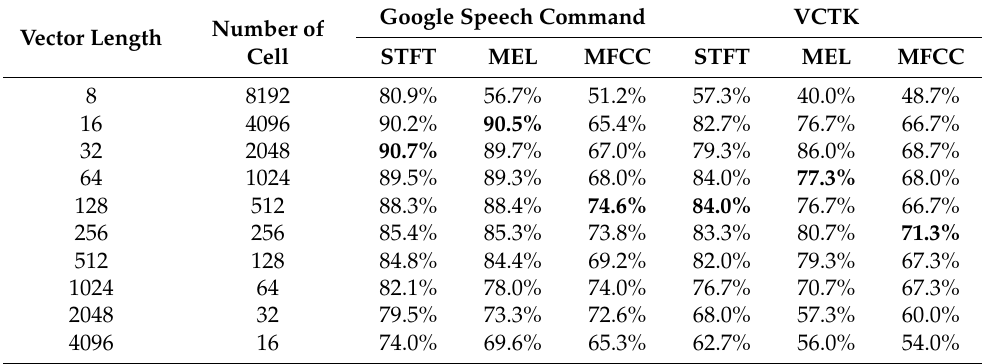
Table 4. Simulation result of speech datasets with 64 KB of